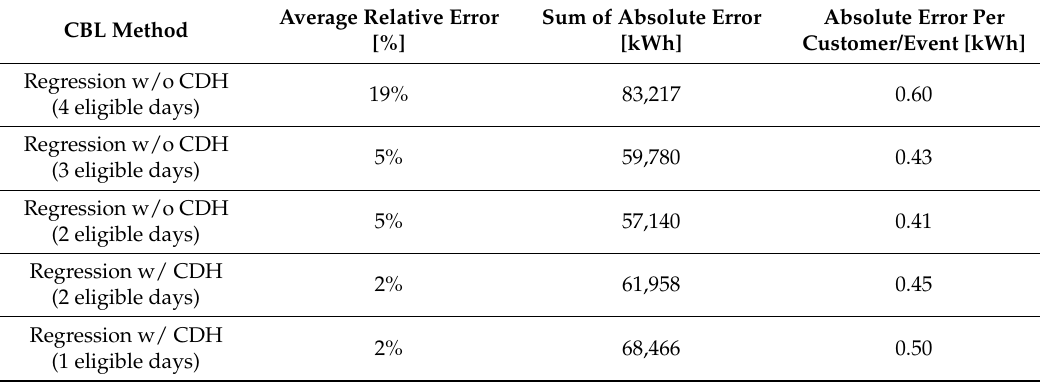
Table 5. CBL estimation evaluation results for the considered regression